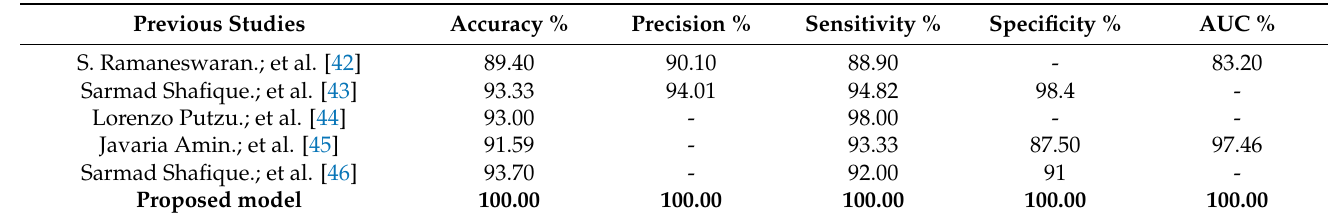
Table 8. Comparing the performance of the proposed systems with the performance of the relevant previous studies.